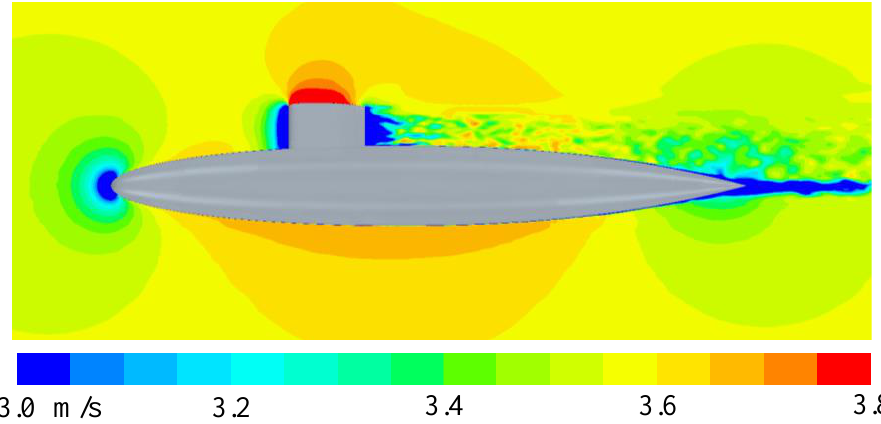
Figure 8. Velocity field of longitudinal section in underwater vehicle with sail.